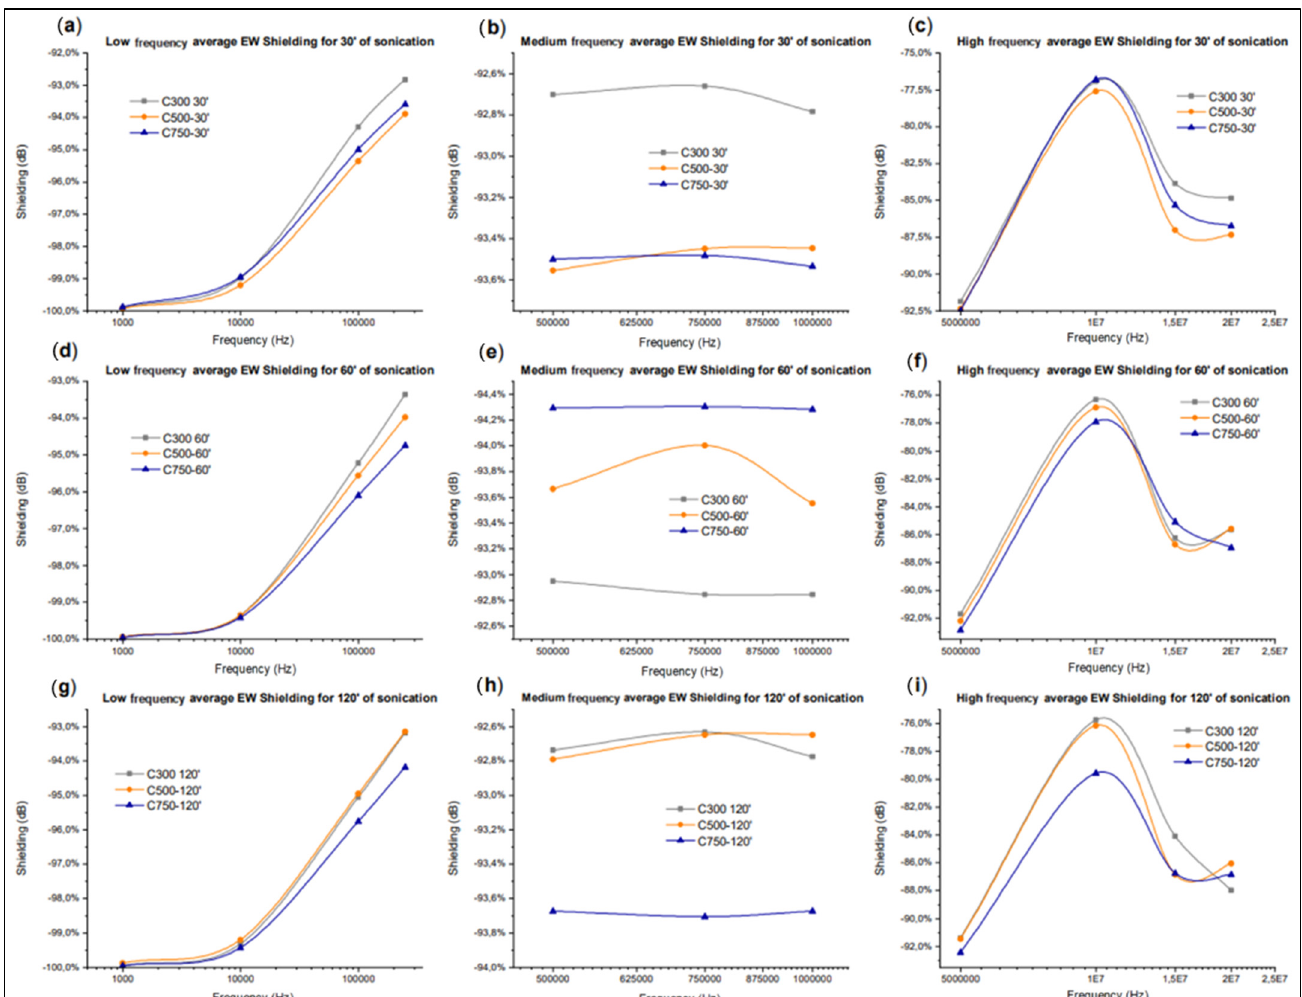
Figure 18. Amplitude attenuation values of the propagated electrical signal for the three types of GNP C used according to the sonication time employed and the frequency band studied. For the low ( a , d , g ), medium ( b , e , h ), and high ( c , f , i ) frequency band, the values for 30 min ( a – c ), 60 min ( d – f ), and 120 min ( g – i ) are shown.